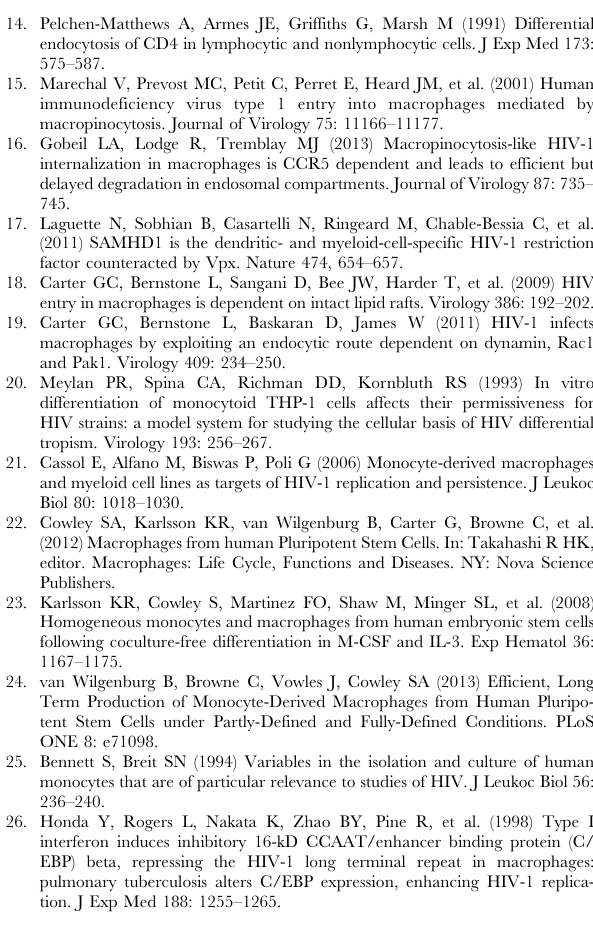
using specific primers. Symbols represent the mean number of copies 6 SEM from technical replicates (n= 3) using pooled DNA from three independent experiments of chimeric CD4 relative to the CD4 WT group. B) To detect chimeric CD4 transcripts, RNA was isolated from transgenic PSC-macrophages and analysed by RT-qPCR using specific primers. Symbols represent the relative mean number of copies of transgenic chimeric CD4 mRNA using pooled RNA from three independent experiments. C) To detect protein expression of CD4, transgenic PSC-macrophages lysates were analysed by western blotting using anti-CD4 antibody. GAPDH, a loading control, was detected using anti- GAPDH antibody. Representative blot is shown. D) Protein levels were measured with Odyssey software (Li-COR) and CD4 expression was normalised to GAPDH expression. Symbols represent normalised CD4 expression, relative to the PSC- macrophages control group (shown in Figure 4) of three independent experiments 6 SEM (n= 3). Figure S4 Surface expression of chimeric CD4 in PSC- macrophages. A) PSC-macrophages were tested for surface CD4 expression by flow cytometry using three different clones of anti-CD4 antibodies. Representative histogram showing CD4 surface staining with mAb clone 11830 (red/brown line, recognises both endogenous human and chimeric CD4) is shown in Figure 6E. Staining with mAb clone OKT4 (blue line, left panel, recognises endogenous human CD4 only); or with mAb clone